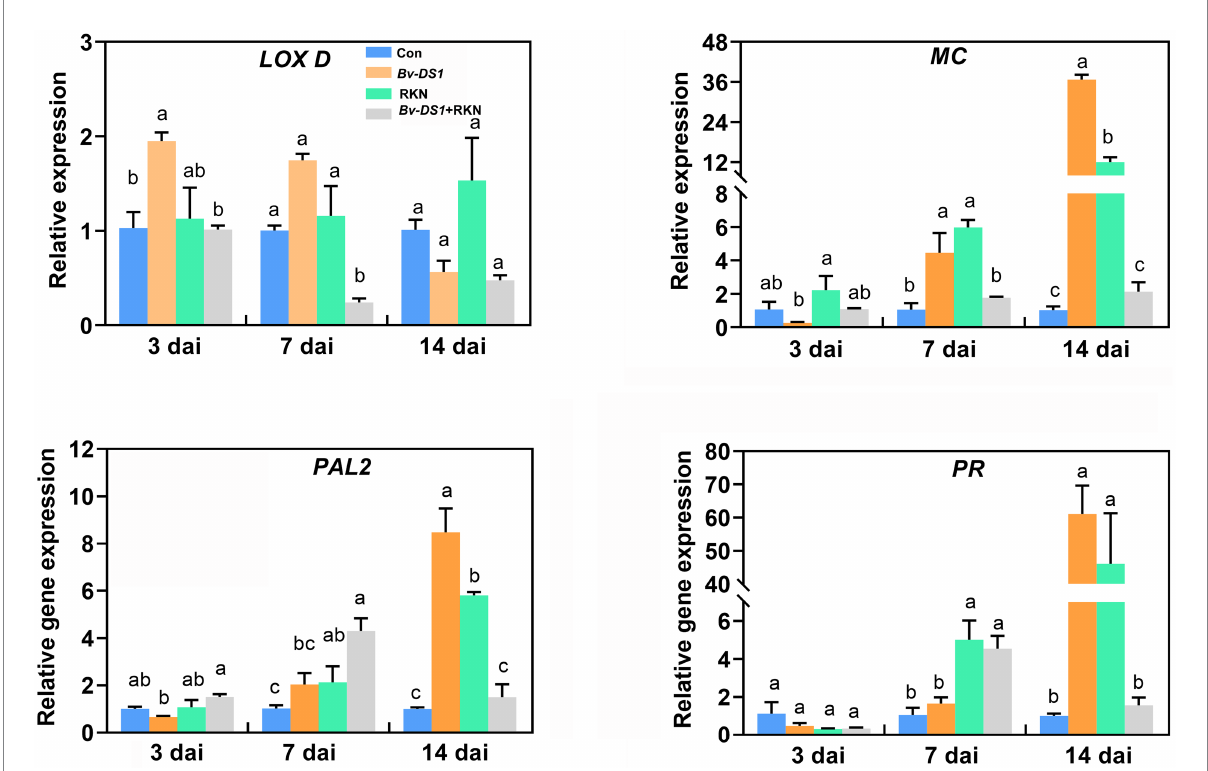
FIGURE 6 Expression levels of defence-related genes were determined in tomato roots non-inoculated or pre-inoculated with Bacillus velezensis YS-AT-DS1 at 3, 7, and 14 days after M. incognita inoculation. Relative gene expression level was normalized to the tomato reference gene SIEF . Error bars represent the SE of the mean of three biological replicates for three plant roots for each treatment. Different letters indicate significant differences between treatments ( p < 0.05) according to Tukey’s multiple comparisons test following one-way